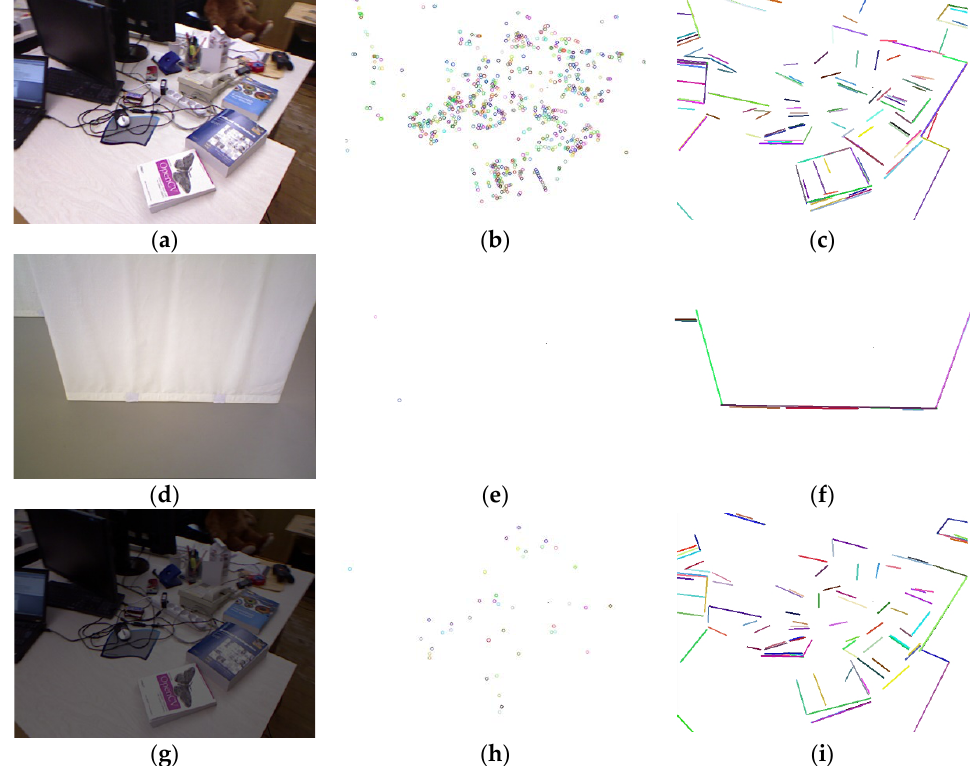
Figure 2. The performance of point and line features in areas of rich texture, low texture, and sudden changes in brightness. ( a , d , g ) A rich-texture scene, low-texture scene, and scene with brightness reduced to 40% of ( a ). We can clearly see that the ORB point features ( b , e , h ) and LSD line features ( c , f , i ) are extracted in the above scene.